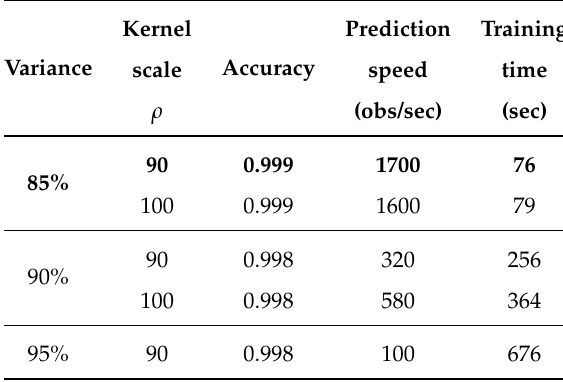
Table 9. Prediction speed and training time results for the best performance cases of each variance (85%, 90% and 95%) using the SVM classification method. The best classifier in terms of accuracy and computational cost is highlighted using a boldface font.